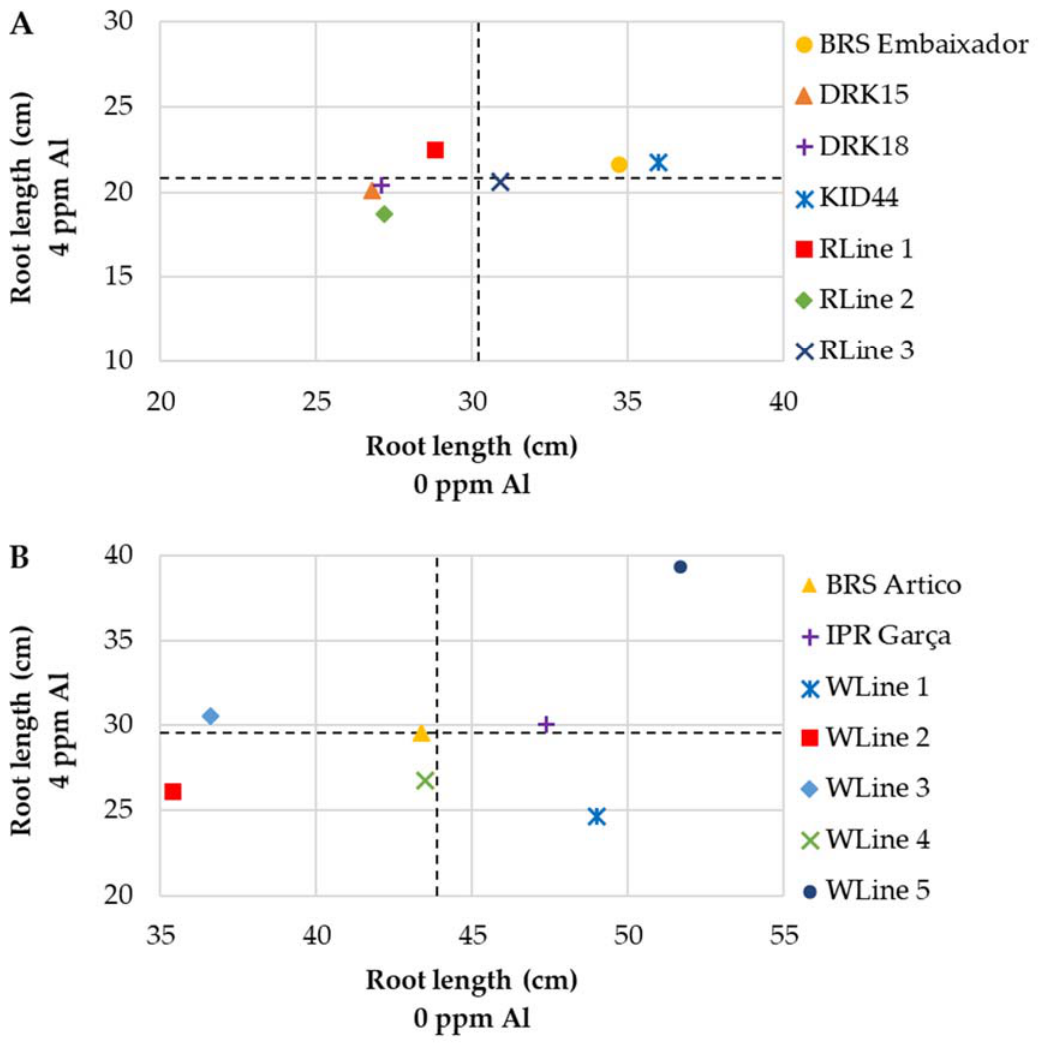
Figure 5. Relationship between root length (cm) of common bean cultivars of the red ( A ) and white market classes ( B ) in nutrient solution grown in Al-free solution (0 ppm) and under Al stress (4 ppm).